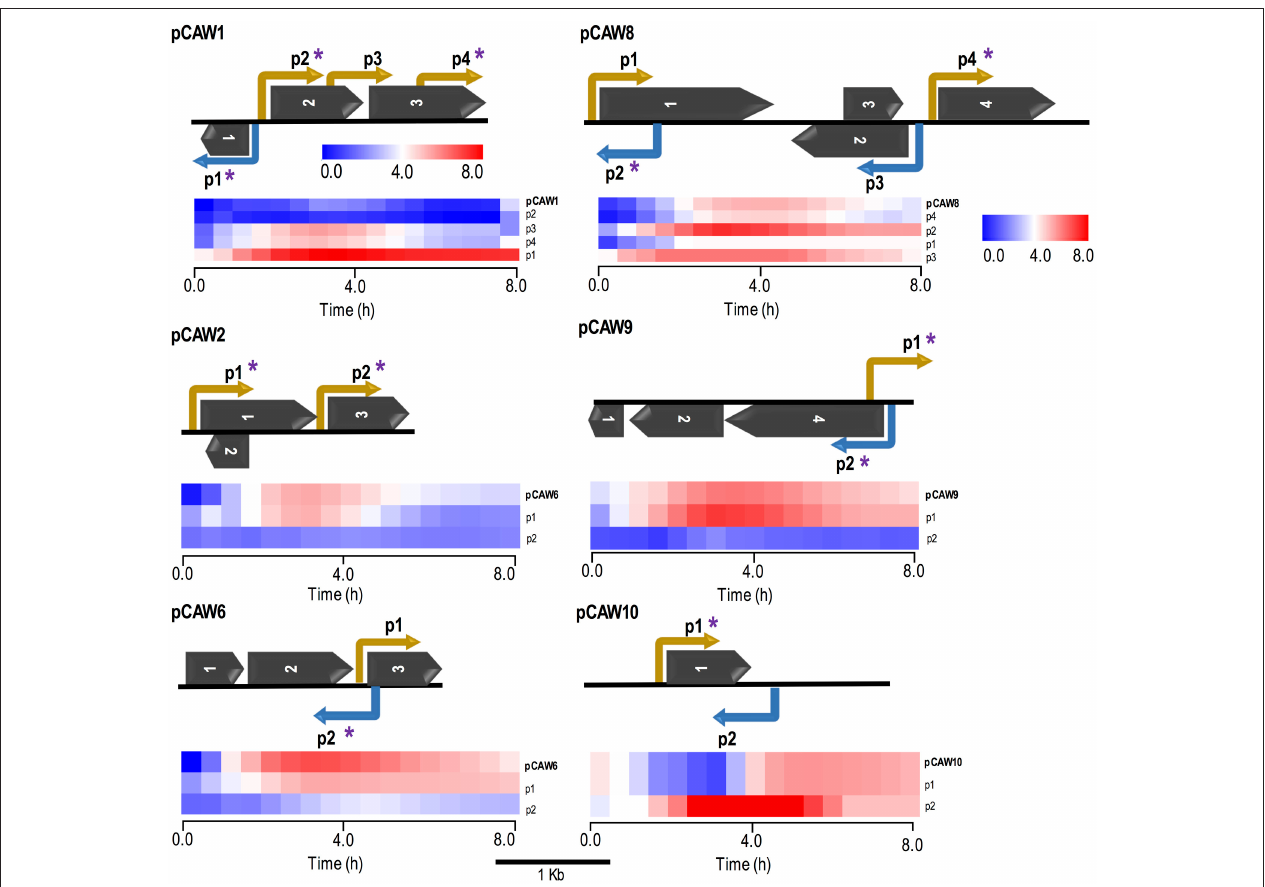
FIGURE 3 | Schematic representation of six metagenomic inserts (contigs) showing predicted ORFs and experimentally validated/characterized promoters. Each contig is identified on the far left of each subfigure. Promoters are indicated by elbow-shaped arrows and name according to their relative position in the contig. Promoter directionality, regarding the leading and lagging strands, is represented by yellow and blue colors, respectively. Asterisks over specific promoters indicate regulatory regions which were cross-validated by matching in silico predictions. Dark arrows represent predicted ORFs, according to their relative positions in each contig (see Table 2 for more information). All genetic features respect their original relative sizes, following the 1kb scale depicted at the bottom of this figure. Beneath each metagenomic insert, there is a heat map cluster representing the whole set of promoter activities measured during 8-h fluorescence assays. The first line of each cluster shows the original expression profile initially measured for each metagenomic insert. All other lines represent expression activities from de novo experimentally validated promoters within each contig (small DNA fragments). The second line of each cluster represents the endogenous promoter showing the most similar activity with respect to the original expression profile for each contig. All expression profiles are properly identified at the most rightmost side of each line, following their respective contig/promoter name. For the supplementary set of analyzed contigs, see Figure